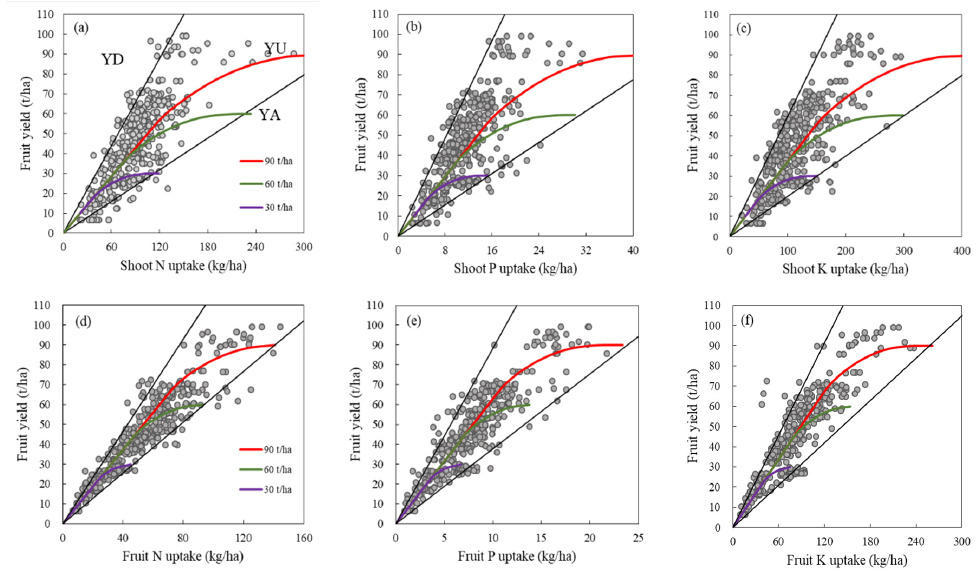
Figure 4. Relationships between fruit yield and N, P, and K accumulation in the shoot dry matter ( a – c ) and fruit ( d – f ) under different potential yields predicted by the Quantitative Evaluation of the Fertility of Tropical Soils (QUEFTS) model. YD, YA, and YU represent the maximum dilution, maximum accumulation, and balanced uptake of N, P, and K in the shoot dry matter or in the fruit dry matter, respectively. These parameters were calculated by the QUEFTS model after excluding the upper and lower 5th percentiles of all internal efficiency data (HI ≥ 0.4). The potential yield ranged from 30 to 90 t/ha.